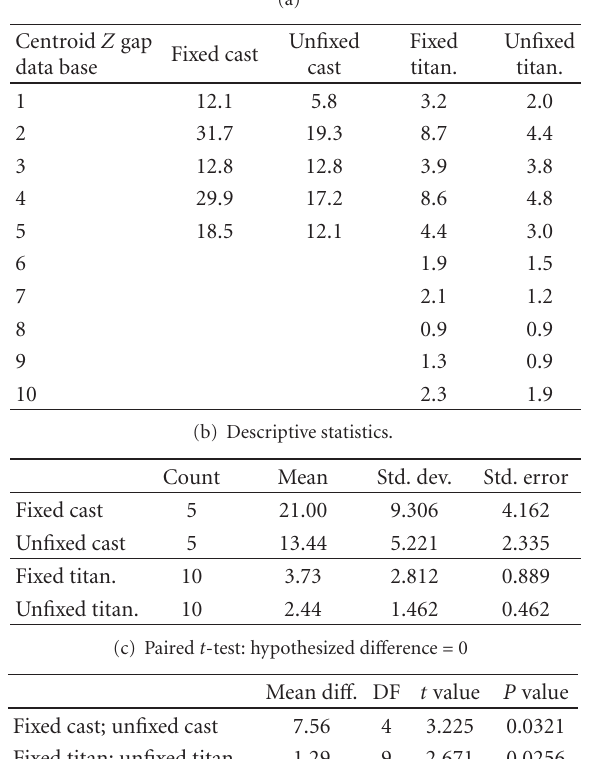
Table 8: Comparison of the best-fit results in µ m for centroid vertical gaps generated by the fixed and unfixed coordinate system best-fit matching